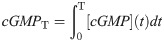
Relative cGMPT levels after single, paired, and triple kinetic perturbations of the oxidatively impaired NO˙-cGMP pathway.The relative level of cGMPT as a function of all possible single (13 brown bars), paired (78 gray bars), and triple (286 green bars) perturbations is shown. Values of the rate constants were reduced to 10% of their original values (S1 Table). Each bar shows the relative integrated cGMP levels over the period of simulation, or cGMPT=∫0T[cGMP](t)dt. Note that some of the optimal perturbations are highlighted in this figure.